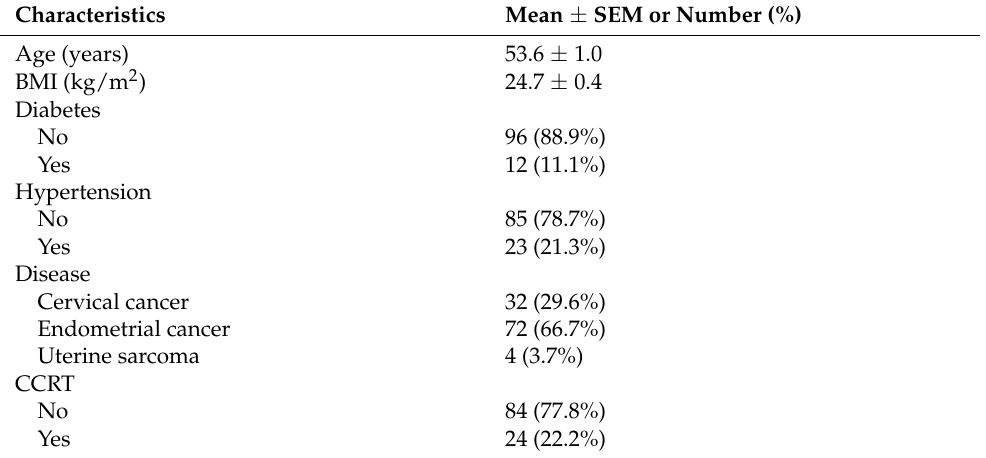
Table 1. Characteristics of patients ( n =